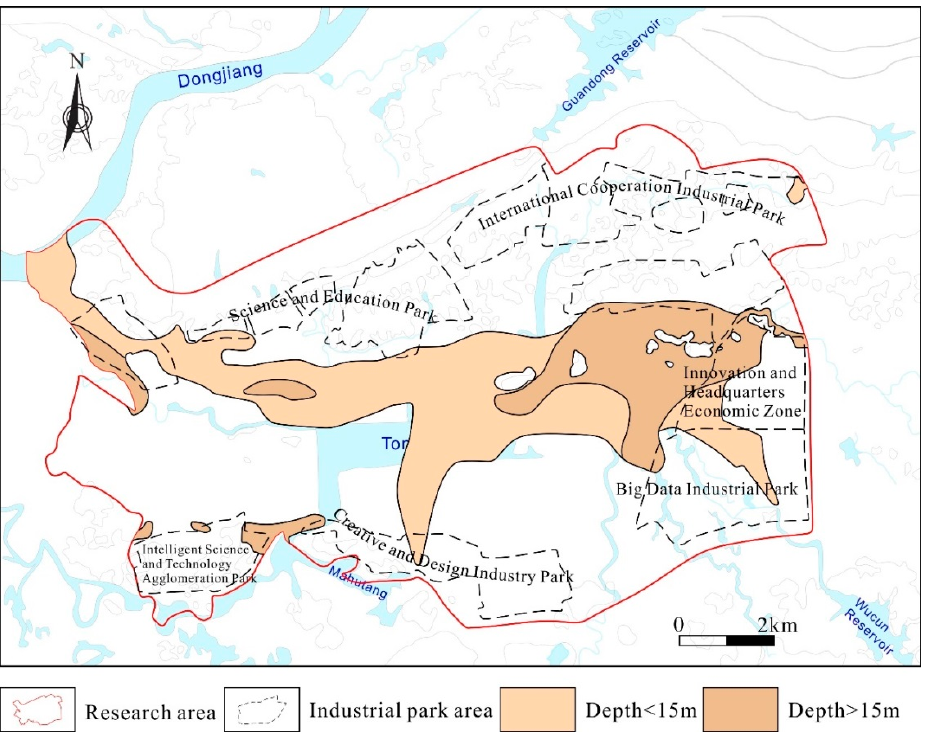
Figure 7. Distribution of sand in the study area. Table 2. Di ff erences in the mechanical properties of soils in the study